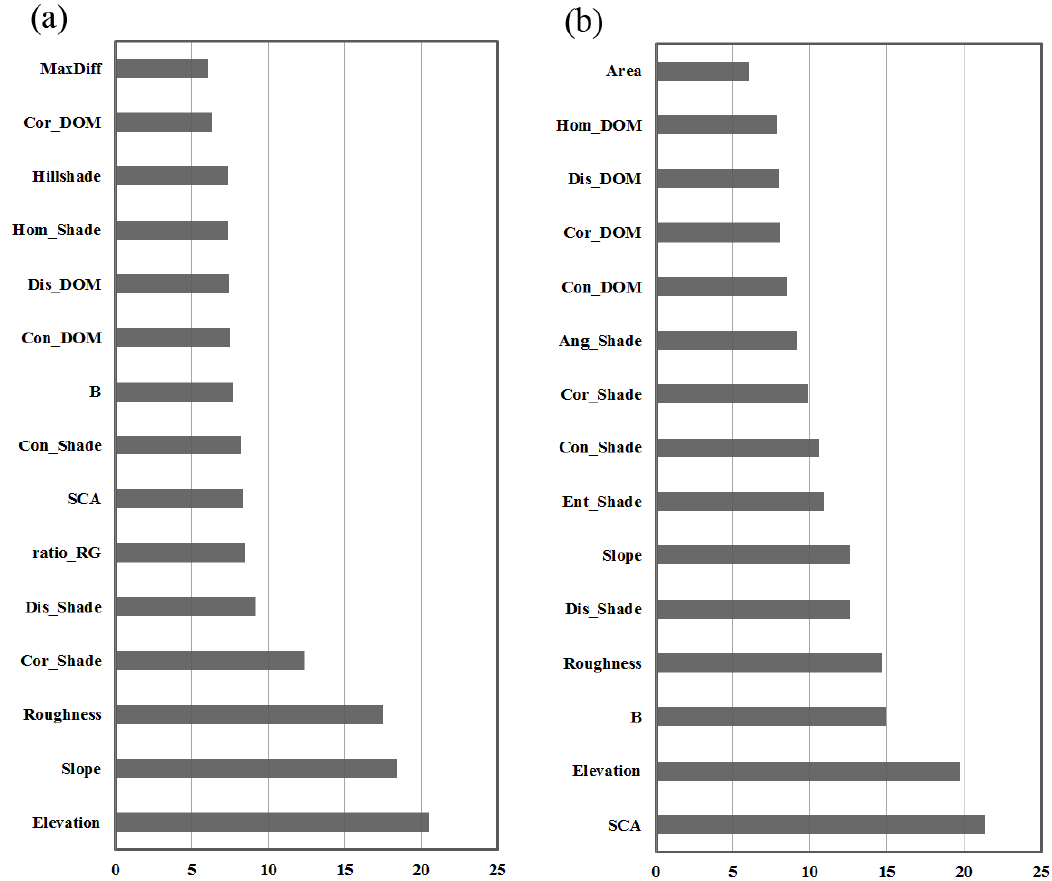
Figure 8. Feature importances for: ( a ) Changwu; and ( b ) Ansai.